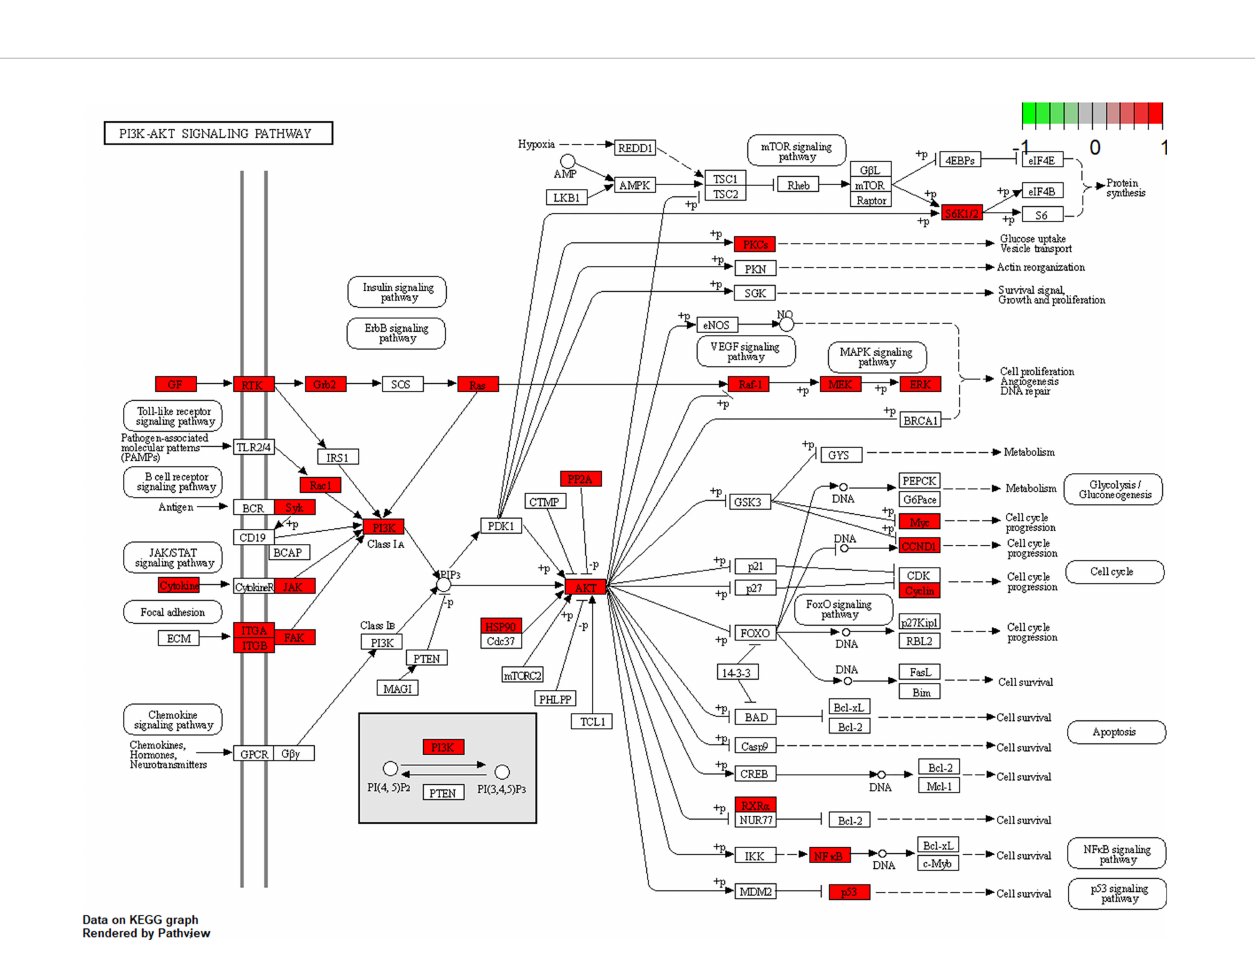
FIGURE 6 | The maps of PI3K/AKT signaling pathway. The white rectangles and red rectangles represent unidenti fi ed proteins and identi fi ed proteins,